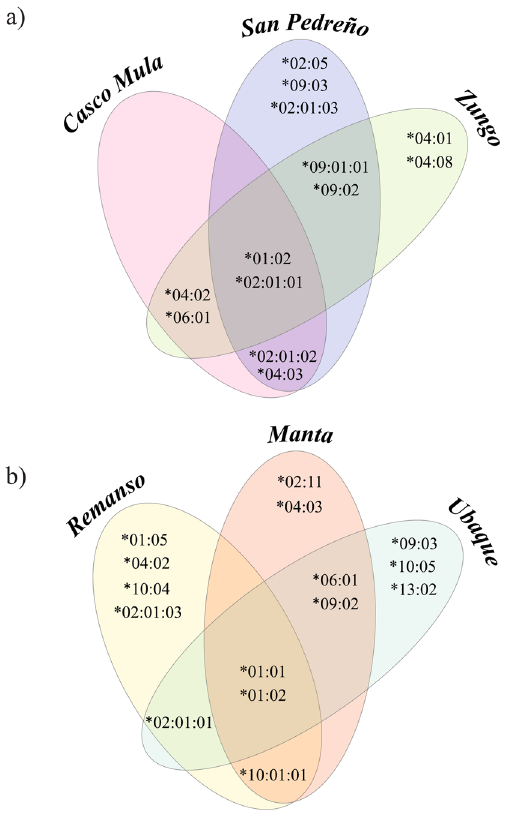
Figure 2. Venn diagram comparing the distribution of specific and shared SLA-DRB1 alleles according to the target population. ( a ) Creole pigs. ( b ) commercial